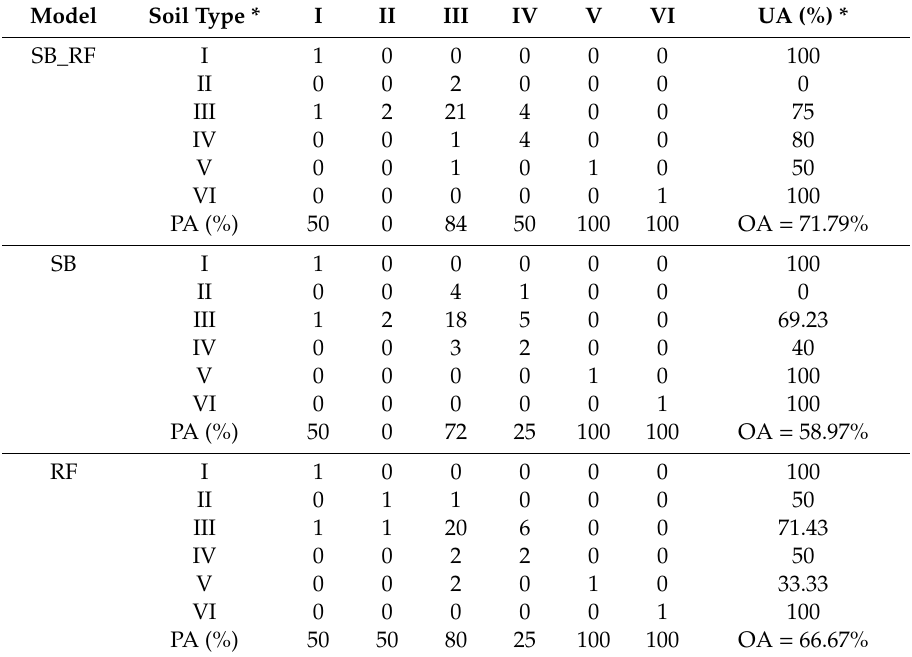
Table 3. Confusion matrices built with the validation samples for the integration of similarity-based approach and random forests (SB-RF), similarity-based approach (SB), and random forests (RF).